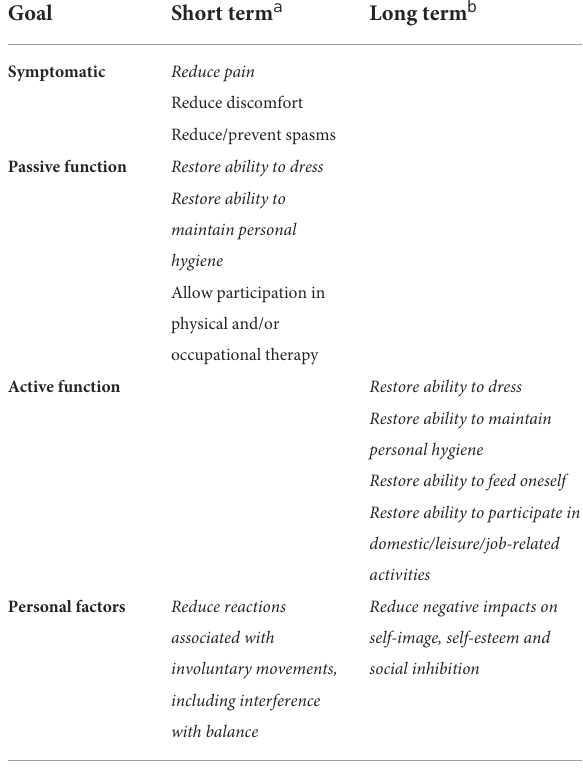
TABLE 3 Goals of BoNT-A treatment in the shoulder for patients with upper limb